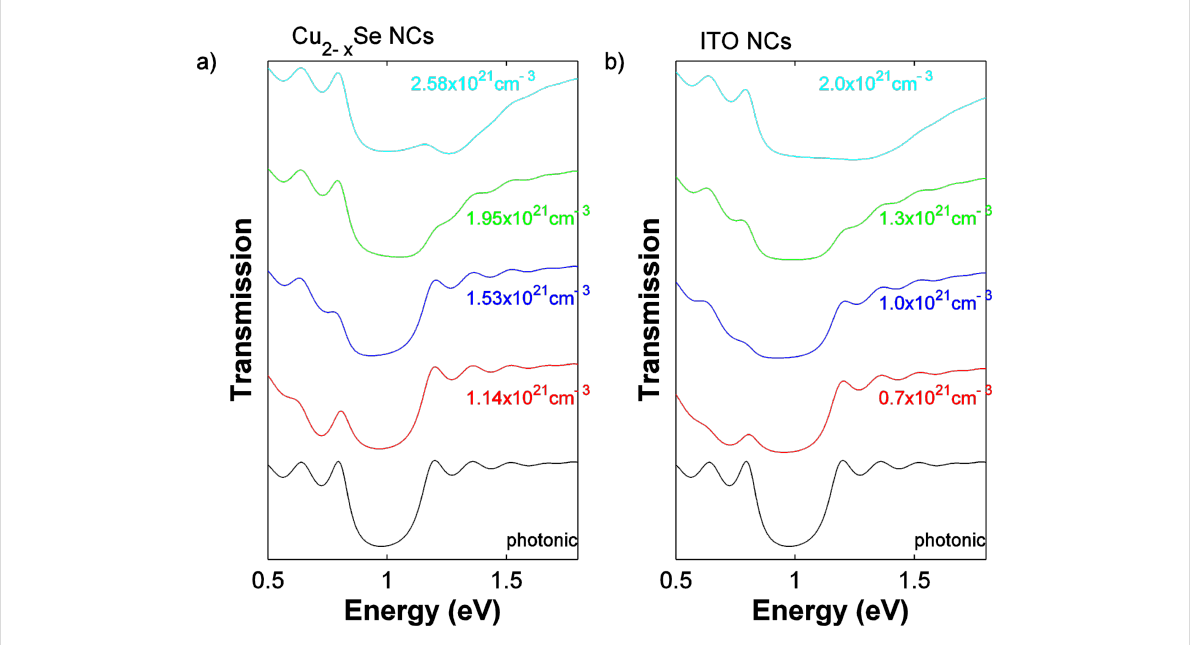
Figure 4: Transmission of the tunable light filter for a Bragg mirror coupled to a) a Cu 2 − x Se NCs dispersion and b) to an ITO NC film with varying carrier concentrations representing the band gap tuning of the Bragg mirror. The black curves correspond to the bare Bragg mirror. In both presented devices, the filtering covers a broader range which is blue shifted (for higher carrier concentrations) and red shifted (for lower concentrations), repre- senting the tunability of the filter upon carrier density modulation in the heavily doped semiconductor NC